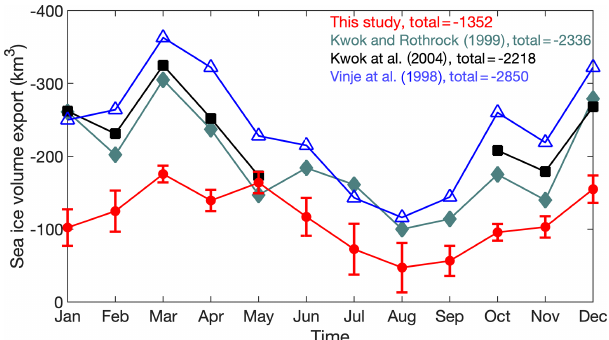
Figure 15. Monthly mean sea ice volume export (unit: km 3 ) at the 79 ◦ N transect in the Fram Strait from this study (red line), Kwok and Rothrock (1999, dark green line), Kwok et al. (2004, black line), and Vinje et al. (1998, blue